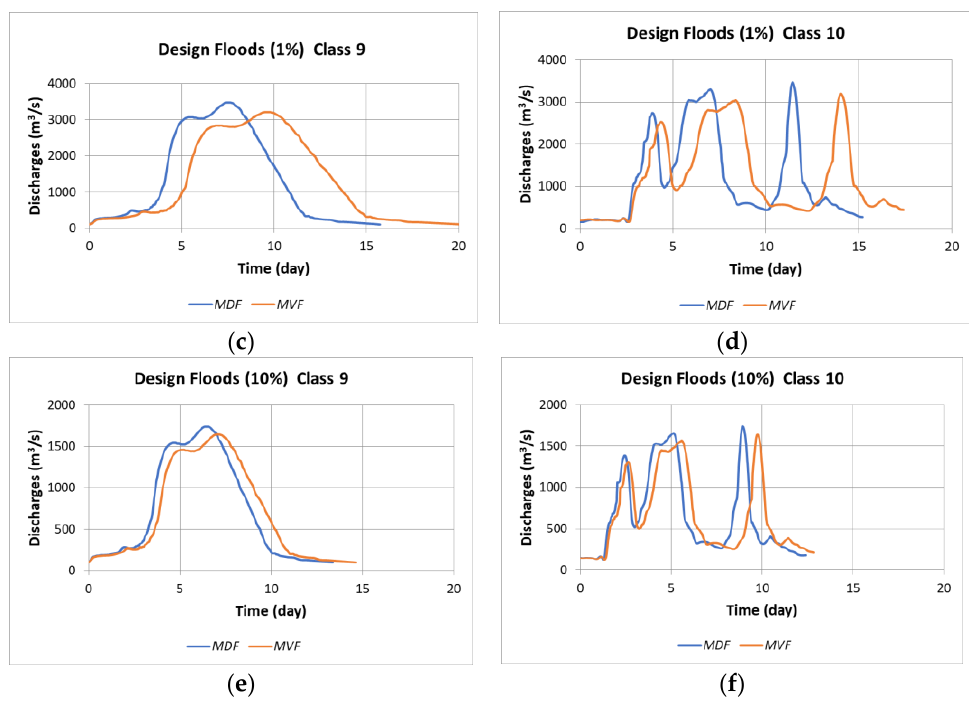
Figure 10. Maximum discharge flood and maximum volume flood (Rădăuți -Prut gauge station). Legend: MDF — blue solid line; MVF — orange solid line. ( a , c , e ) Class 9. ( b , d , f ) Class 10. ( a , b ) Q 0.1%; ( c , d ) Q 1%; ( e , f ) Q 10%.